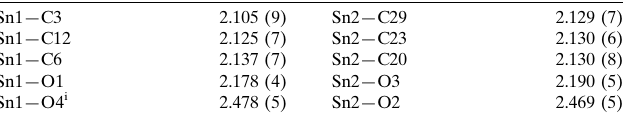
Selected bond lengths (A˚